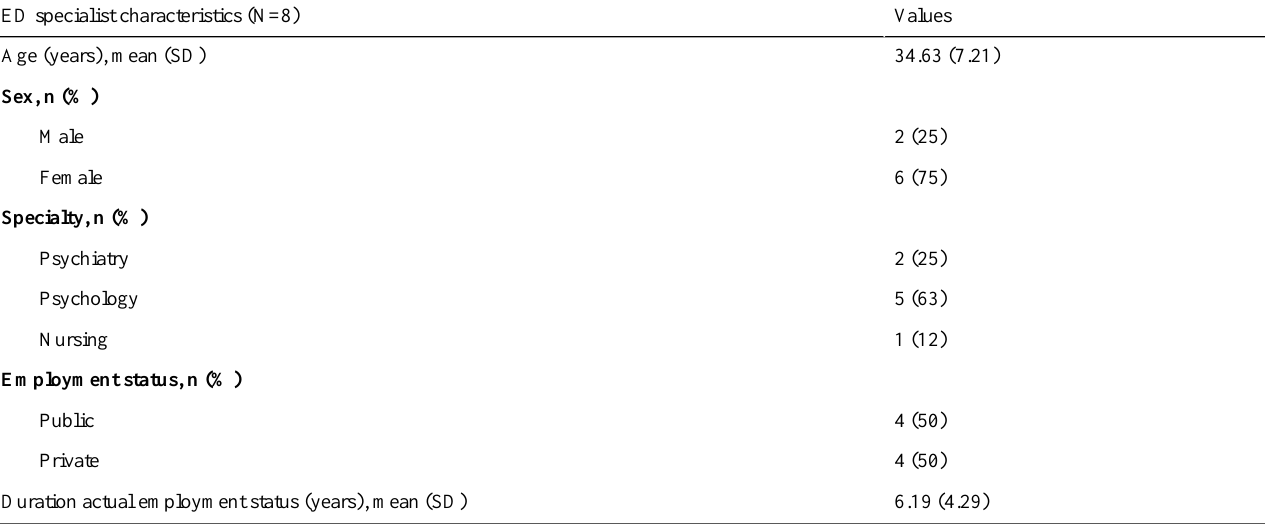
Table 2. Description of eating disorder